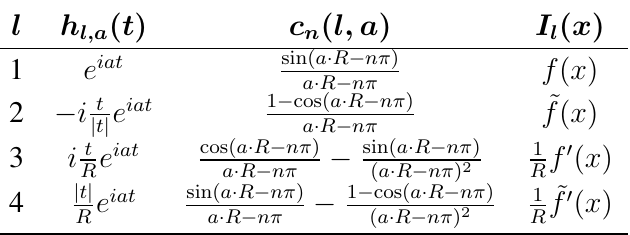
Table 1. Fourier coefficients c satisfying